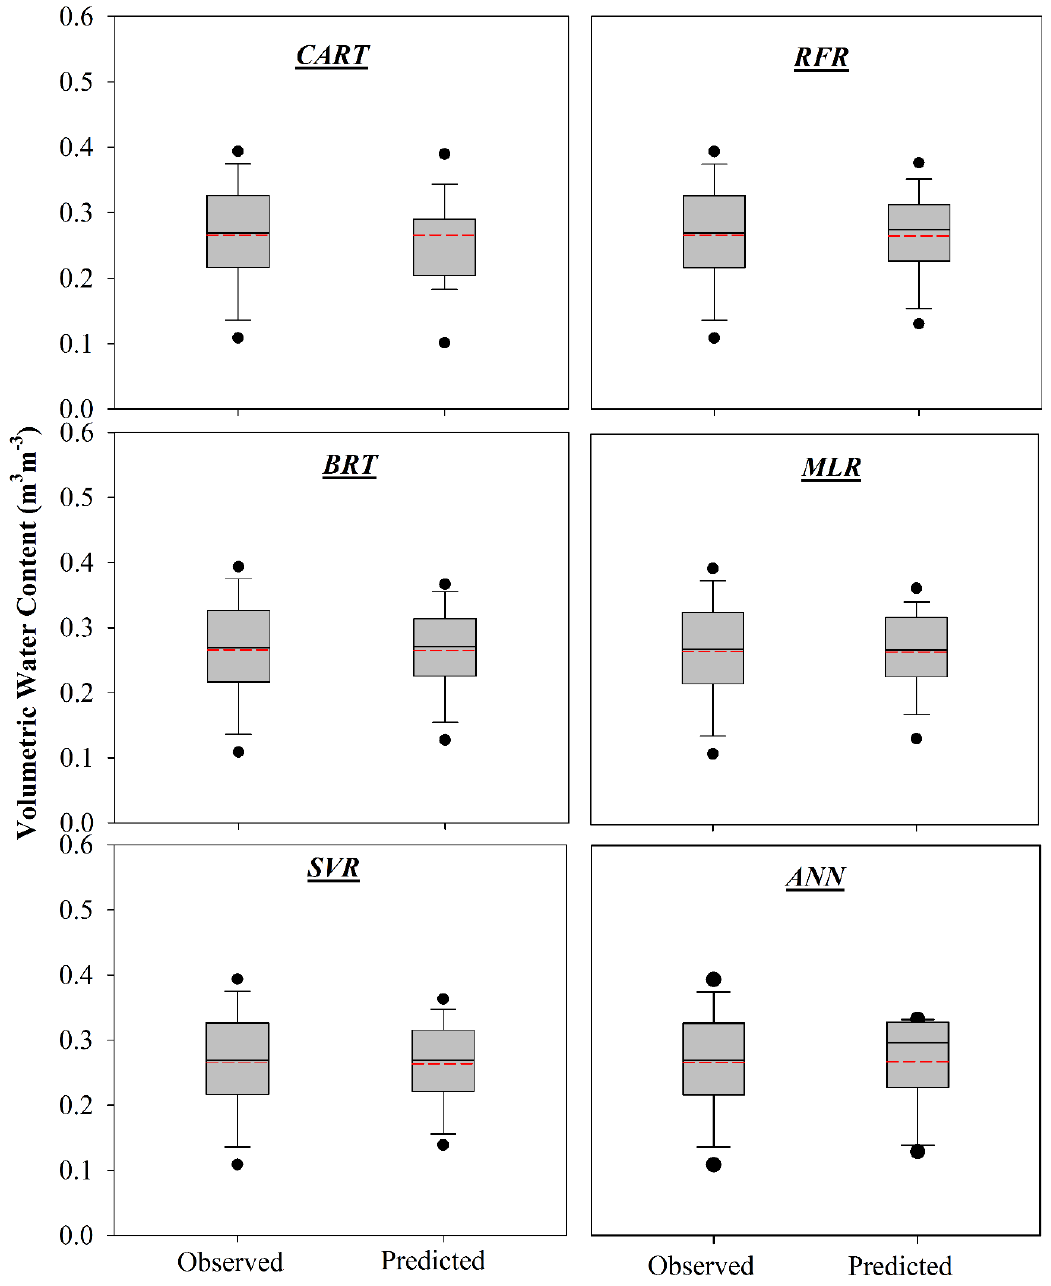
Figure 3. Box plots depicting the spread of observed and predicted soil moisture (m 3 m − 3 ) during the testing phase for 6 different machine learning models. The box shows the interquartile range (25th – 75th percentile). The whiskers extend from 5th to 95th percentile values. The solid line inside the box shows the median value (50th percentile) and the dashed line represents the mean value of the observed soil moisture during testing phase. Algorithms included classification and regression trees (CART), multiple linear regression (MLR), random forest regression (RFR), support vector regression (SVR), boosted regression trees (BRT), and artificial neural networks (ANN).